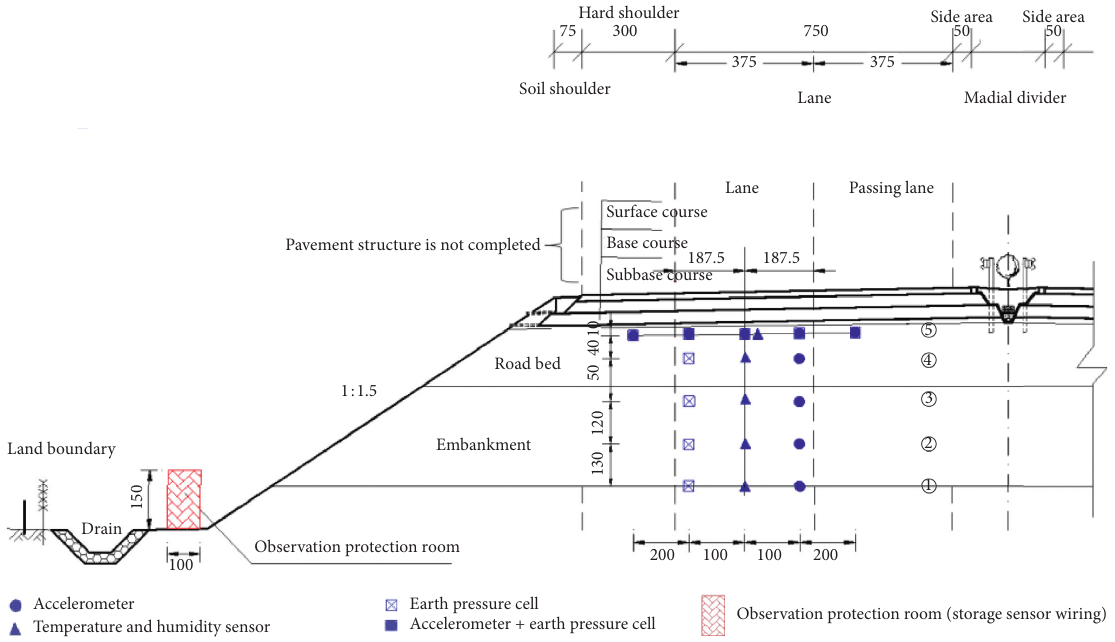
Figure 2: Schematic of the field sensor layout.